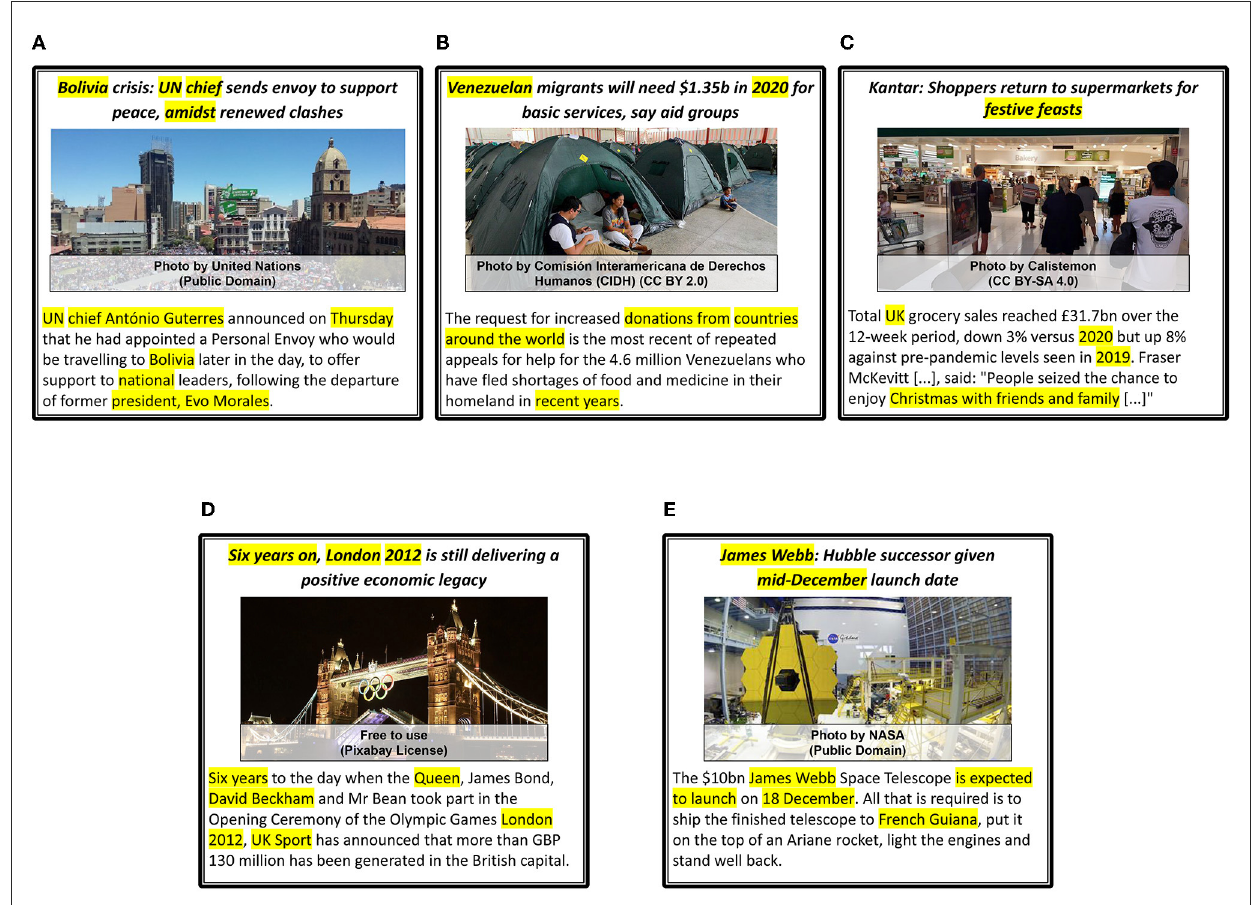
FIGURE10 Proximity , Timeliness , and Eliteness news values examples. All news values except domain proximity are described as Category, (textual or visual cues), [Modalities: I (image), T (Text)] . The segments in text that mention important words or phrases indicating time, persons, locations, etc. are highlighted (yellow). (A) Eliteness : Yes, (UN chief, President), [T], Geo. proximity : National, (Bolivia), [I,T], Cul. proximity : Culture-free, [I, T], Dom. proximity : (world affairs, politics, crisis), [I,T], Timeliness : Ongoing, (Thursday, Amidst), [T]. (B) Eliteness : No [I, T], Geo. proximity : International, (Venezuela,World), [T], Cul. proximity : Culture-free, [I,T], Dom. proximity : (migration, refugee-crisis) [T], Timeliness : Ongoing, recent, (2020, recent years) [T]. (C) Eliteness : No, [I,T], Geo. proximity : National, (UK) [T], Cul. proximity : Culture-bound, (festive, christmas), [T], Dom. proximity